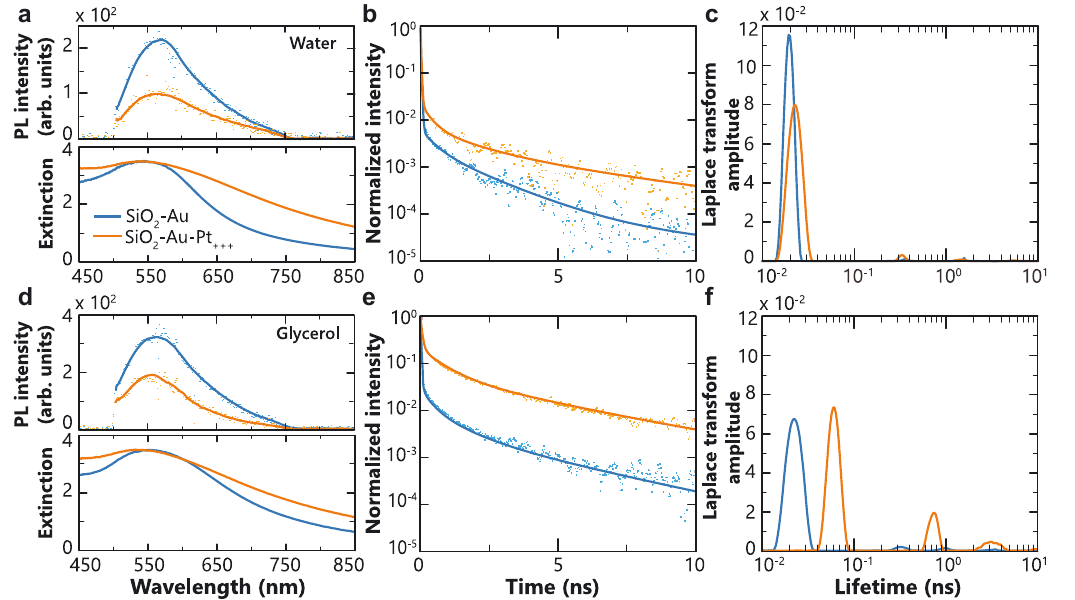
Figure 4: Time-resolved photoluminescence measurements in nanoparticle solutions. (a) and (d) Photoluminescence (top) and extinction (bottom) spectra. (b) and (e) Normalised decay dynamics deconvoluted from the experimental instrumental response function of the system. The solid lines represent the dynamics recovered by applying an inverse Laplace transform to the experimental data (dots). (c) and (f) Laplace transform amplitude of SiO –Au (blue lines) and SiO –Au–Pt +++ (orange lines) nanoparticles in (a)–(c) water and (d)–(f) glycerol. 2 2 The excitation wavelength is 488